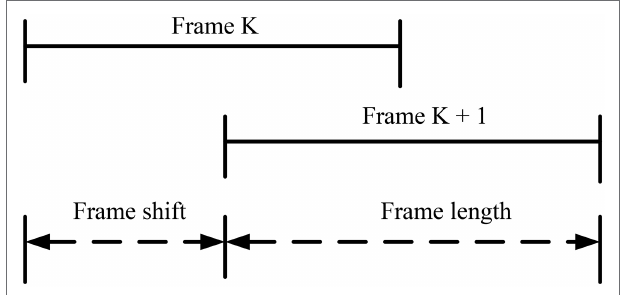
FIGURE 3 | The relationship between frame length and frame